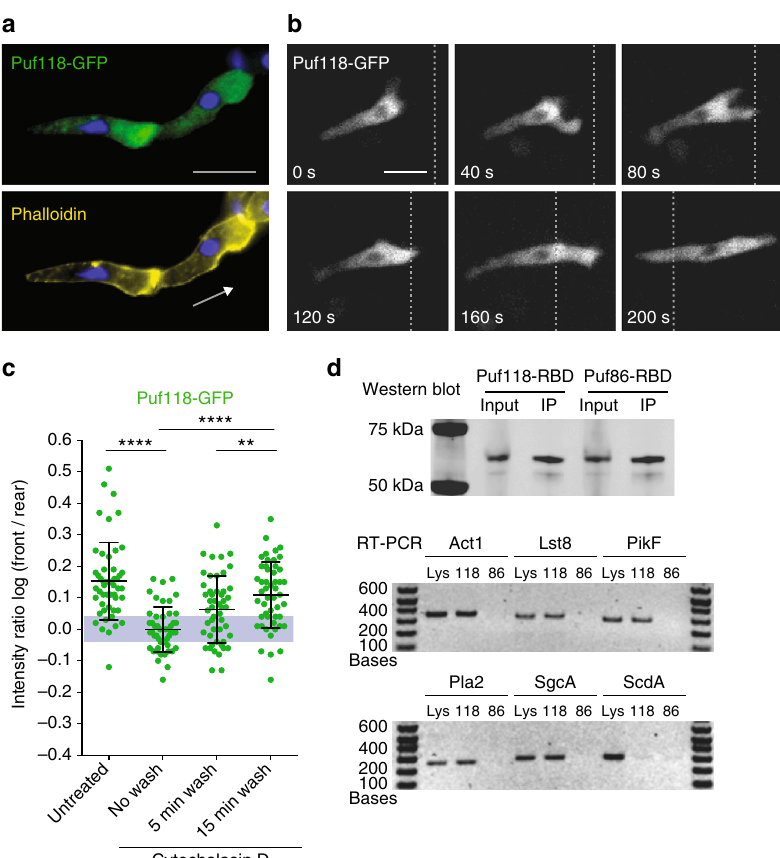
Fig. 2 The RNA-binding protein Puf118 localizes to the cell front and binds chemotaxis pathway mRNAs. a Polarized localization of Puf118-GFP to the cell front in cells migrating in a natural chemotaxis gradient. Arrow indicates orientation of cell polarity de fi ned by F-actin stain (Alexa Fluor 647-conjugated Phalloidin). DNA (nucleus) was stained with DAPI. Scale bar, 10 μ m. b Time-lapse microscopy on Puf118-GFP in a cell migrating in a natural chemotaxis gradient, relative to a fi ducial mark (dotted line). Scale bar, 10 μ m. c Puf118-GFP log F/R before (untreated), during (no wash) and after (wash) incubation with Cytochalasin D. The gray area indicates values equivalent to symmetric localization (between log(0.9) and log(1.1)). Mean and SD, n ≥ 50 cells. Mann – Whitney test: **** p < 0.0001, ** p < 0.01. d Coimmunoprecipitation (IP) of GFP-Puf118-RBD ( “ 118 ” ) and GFP-Puf86-RBD ( “ 86 ” ) with a GFP antibody, and immunoblotted with the GFP antibody (western blot) or processed for RT-PCR for the indicated mRNAs (RT-PCR). “ Lys ” is input lysate